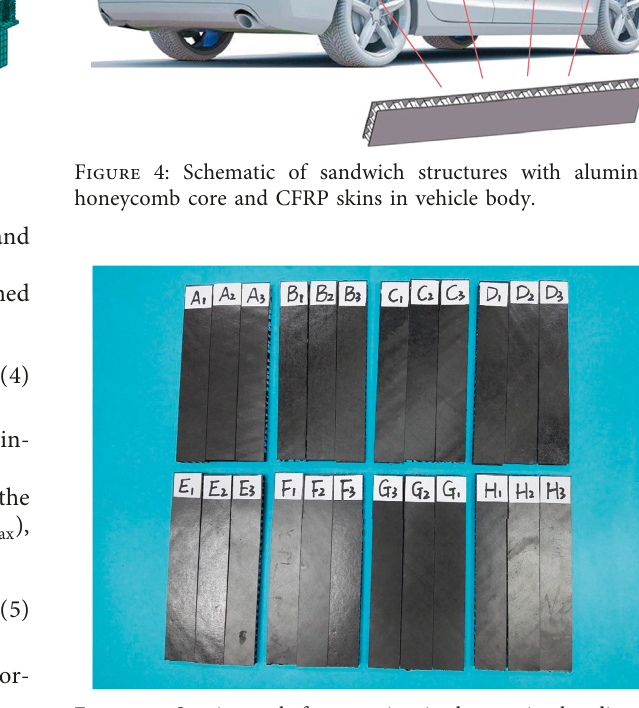
Figure 5: Specimens before quasistatic three-point bending test with different lay-up schemes.